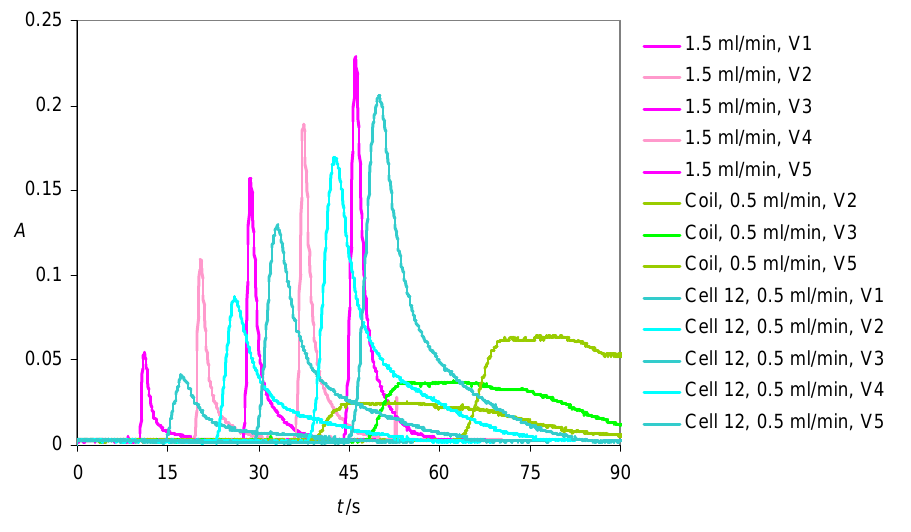
Figure 6. FIAgrams obtained for different dye-injection volumes 8.3 m L (V1), 16.5 m L (V2), 24.8 m L (V3), 33.0 m L (V4) and 41.3 m L (V5), under selected experimental conditions as specified in the